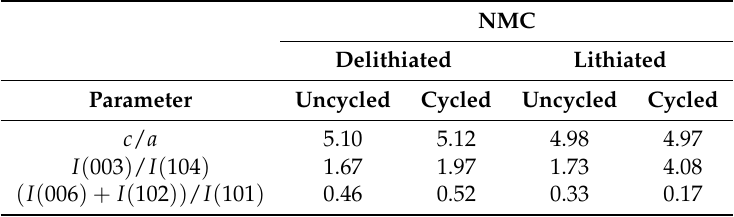
Table 3. Variations of the crystal structure parameters of the electrodes with their lithiation state and